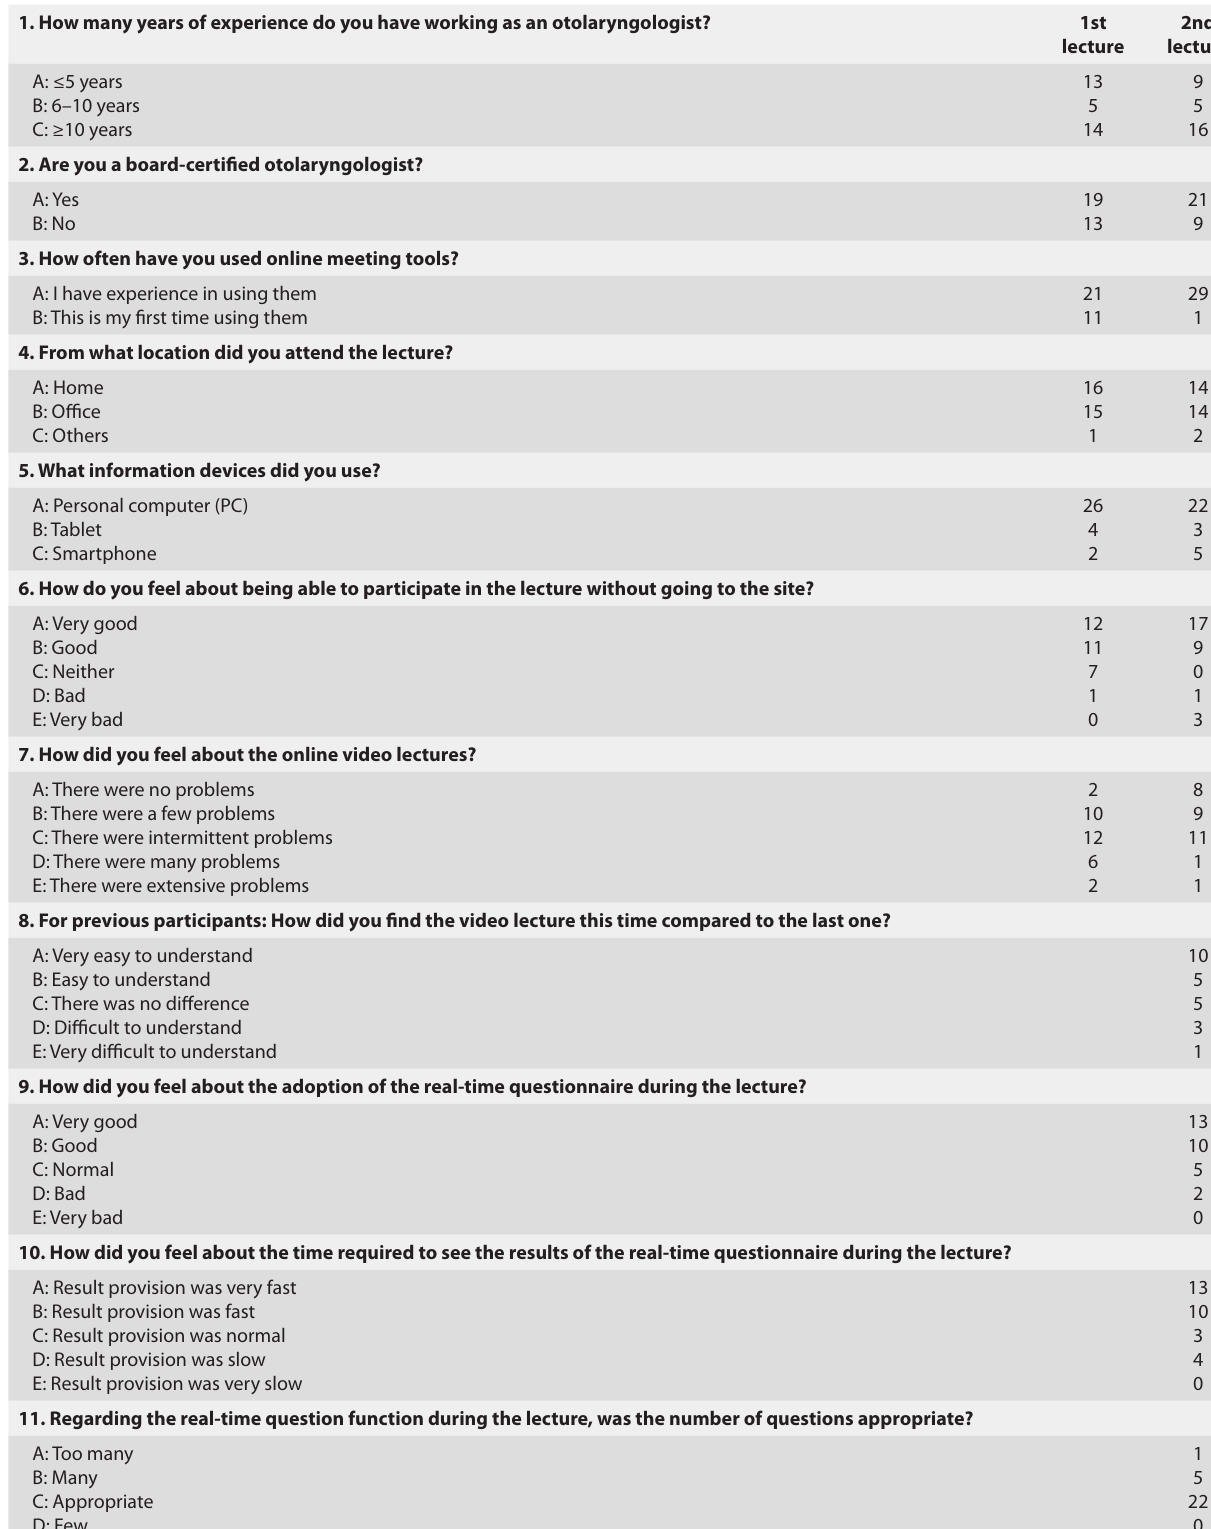
Table 2. Post-survey